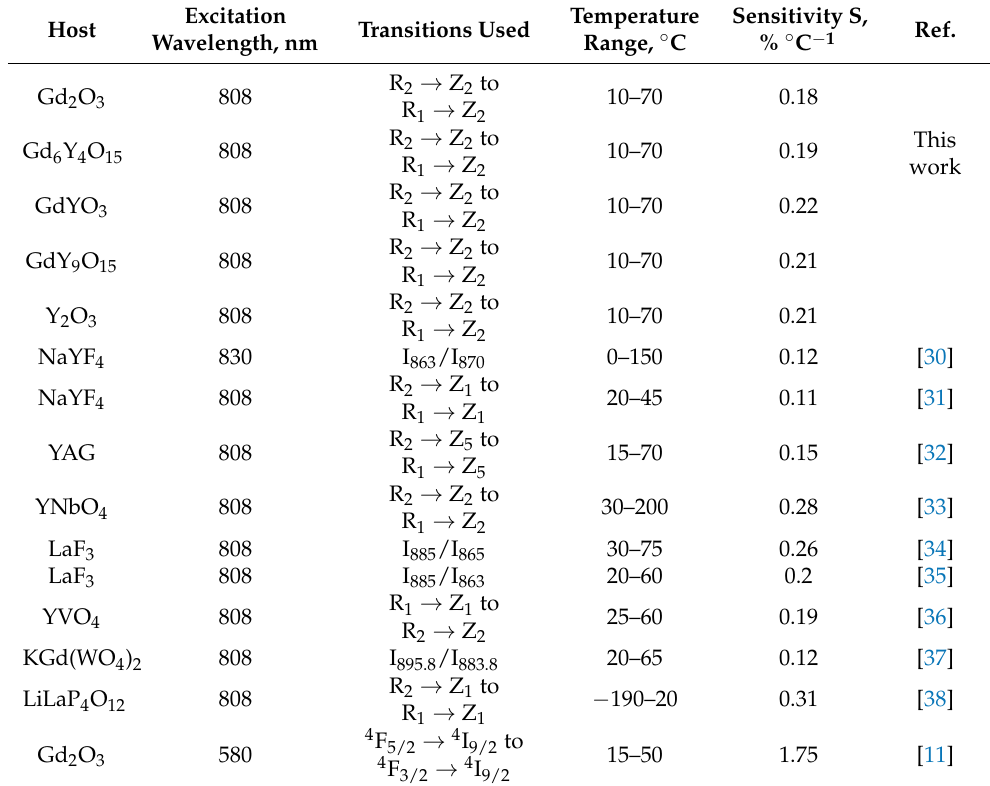
Table 4. Comparison of Nd 3+- doped powders as luminescent